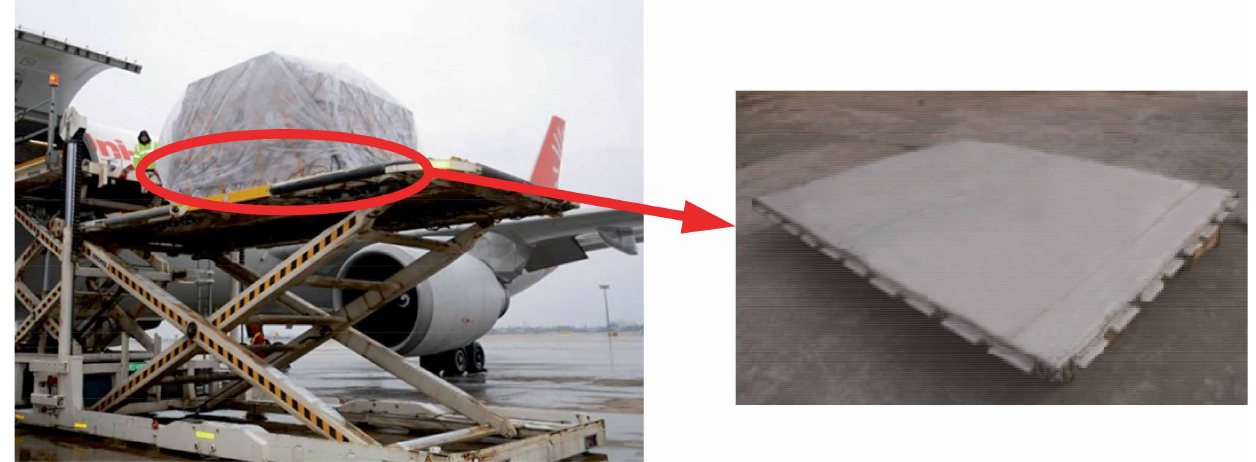
Figure 1: The aircraft pallet